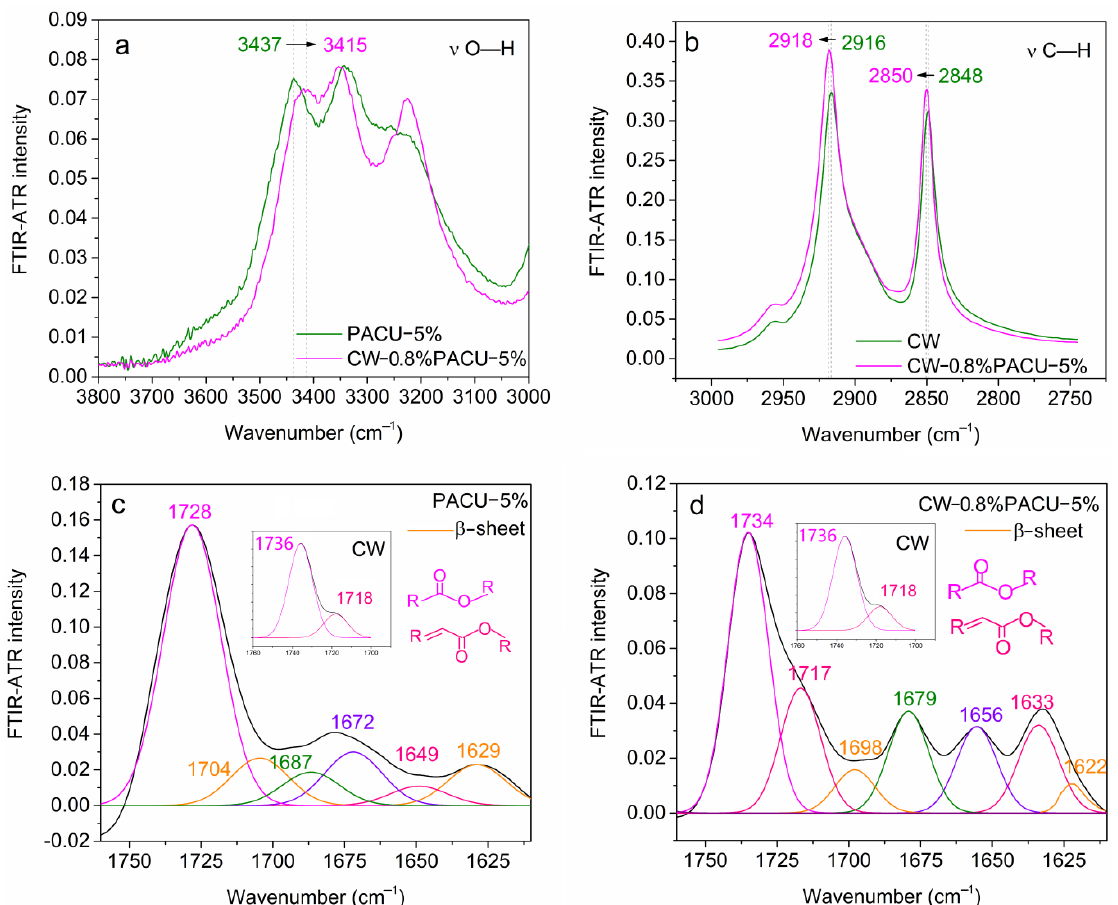
Figure 4. Changes in FTIR-ATR spectra after carnauba wax (CW) modification. ( a ) A redshift of the stretching vibration of O—H after CW modification. ( b ) A blueshift of the stretching vibration of C—H after CW modification. ( c , d ) Deconvolutions of the FTIR esters and diesters of PACU ( c ) and CWPACU ( d ).